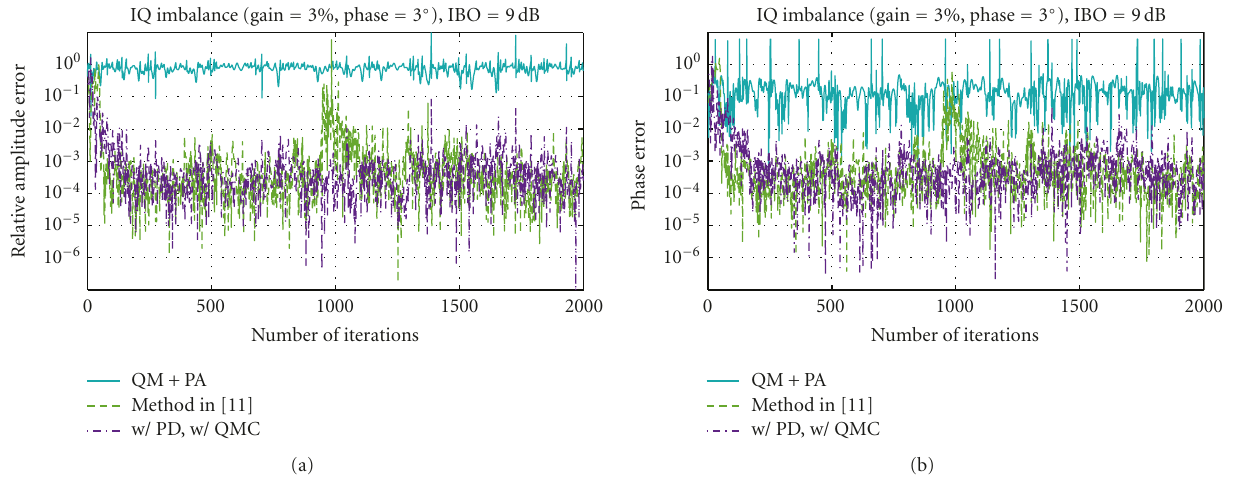
Figure 12: Instantaneous errors between the input and output of the linearized PA with the proposed IQ imbalance compensator (a) relative amplitude error (b) phase error.